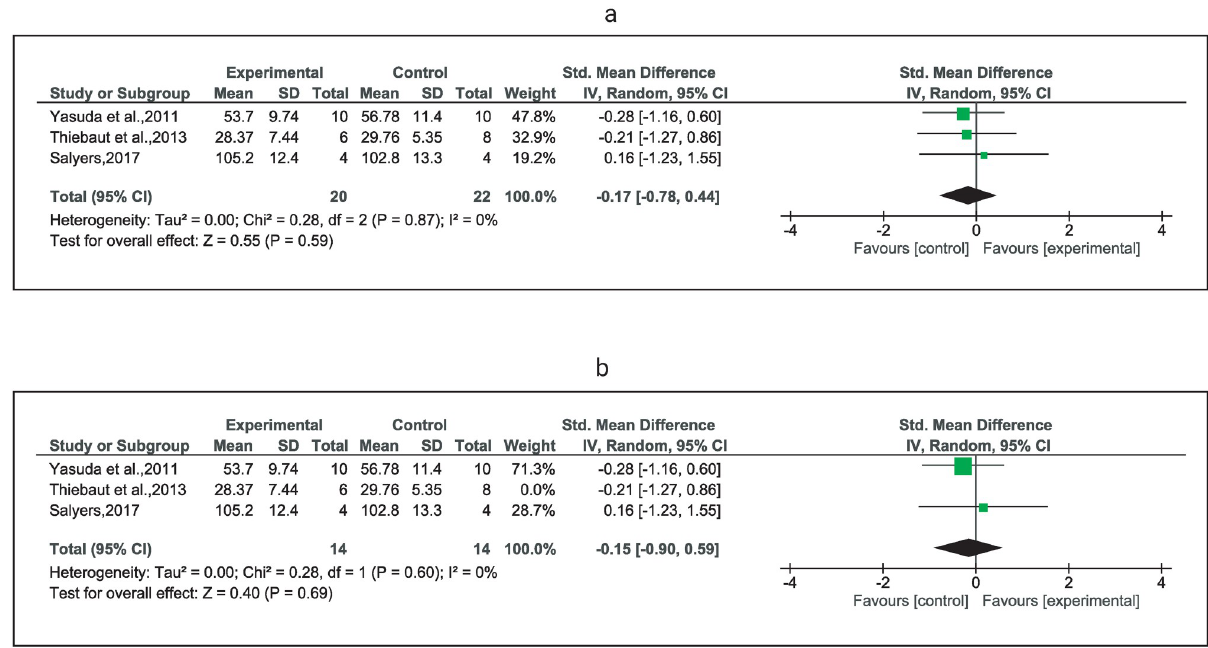
Fig 3. Forest plots depicting studies using LL-BFRT compared to studies using HL-RT in muscle strength. Forest plots comparing low-load resistance training with blood flow restriction (LL-BFRT) and high load resistance training alone HL-RT in strength of: a) chest press (1RM), and b) sensitivity analysis by removing one study (Thiebaud et al., 2013) that included substantially older participants. Abbreviations: CI, confidence interval; IV, inverse variance; Random, random effects model; SD, standard deviation.